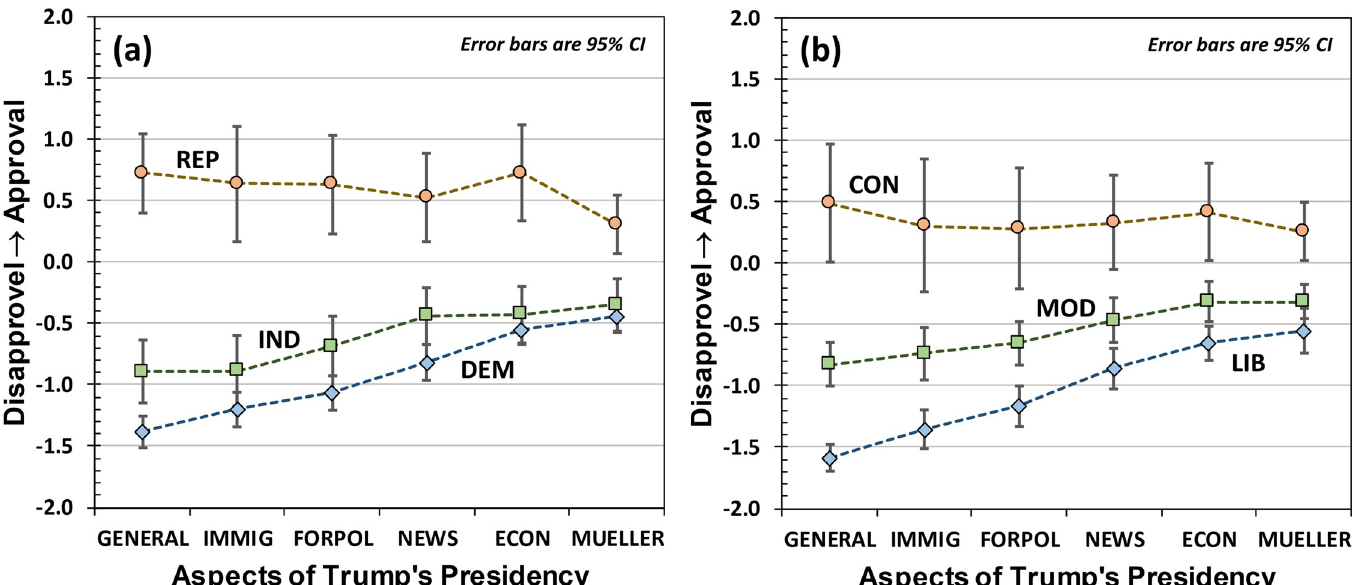
Fig 5. Approval score for various aspects of Trump’s presidency: GENERAL aspects of the presidency, immigration (IMMIG), Foreign Policy (FORPOL), interactions with the news media (NEWS), the economy (ECON), and the Mueller probe (MUELLER). (a) is for Republicans (REP), Independents (IND), and Democrats, (b) is for Conservatives (CON), Moderates (MOD), and Liberals (LIB). Error bars are again 95% confidence intervals.